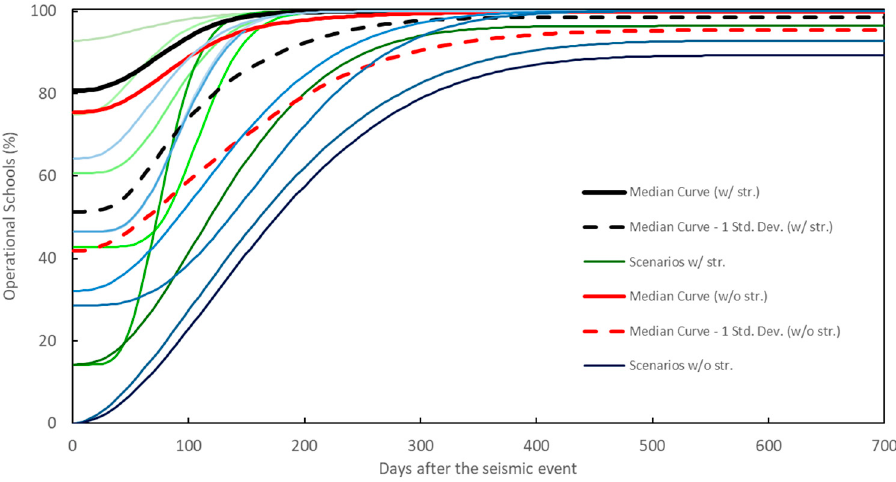
Figure 16. Resilience curves of the school buildings portfolio (28 schools) for seven seismic scenarios, with and without a test strengthening intervention in four schools.